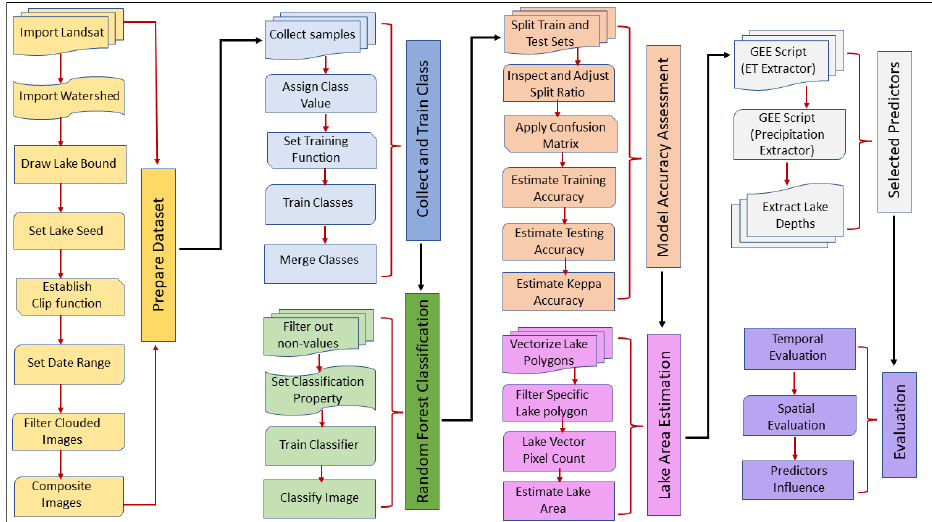
Figure 2. Flowchart of steps for collecting and processing data, and adopting machine learning techniques for estimating lake extent fluctuations. Non-values in this case are the missing values.